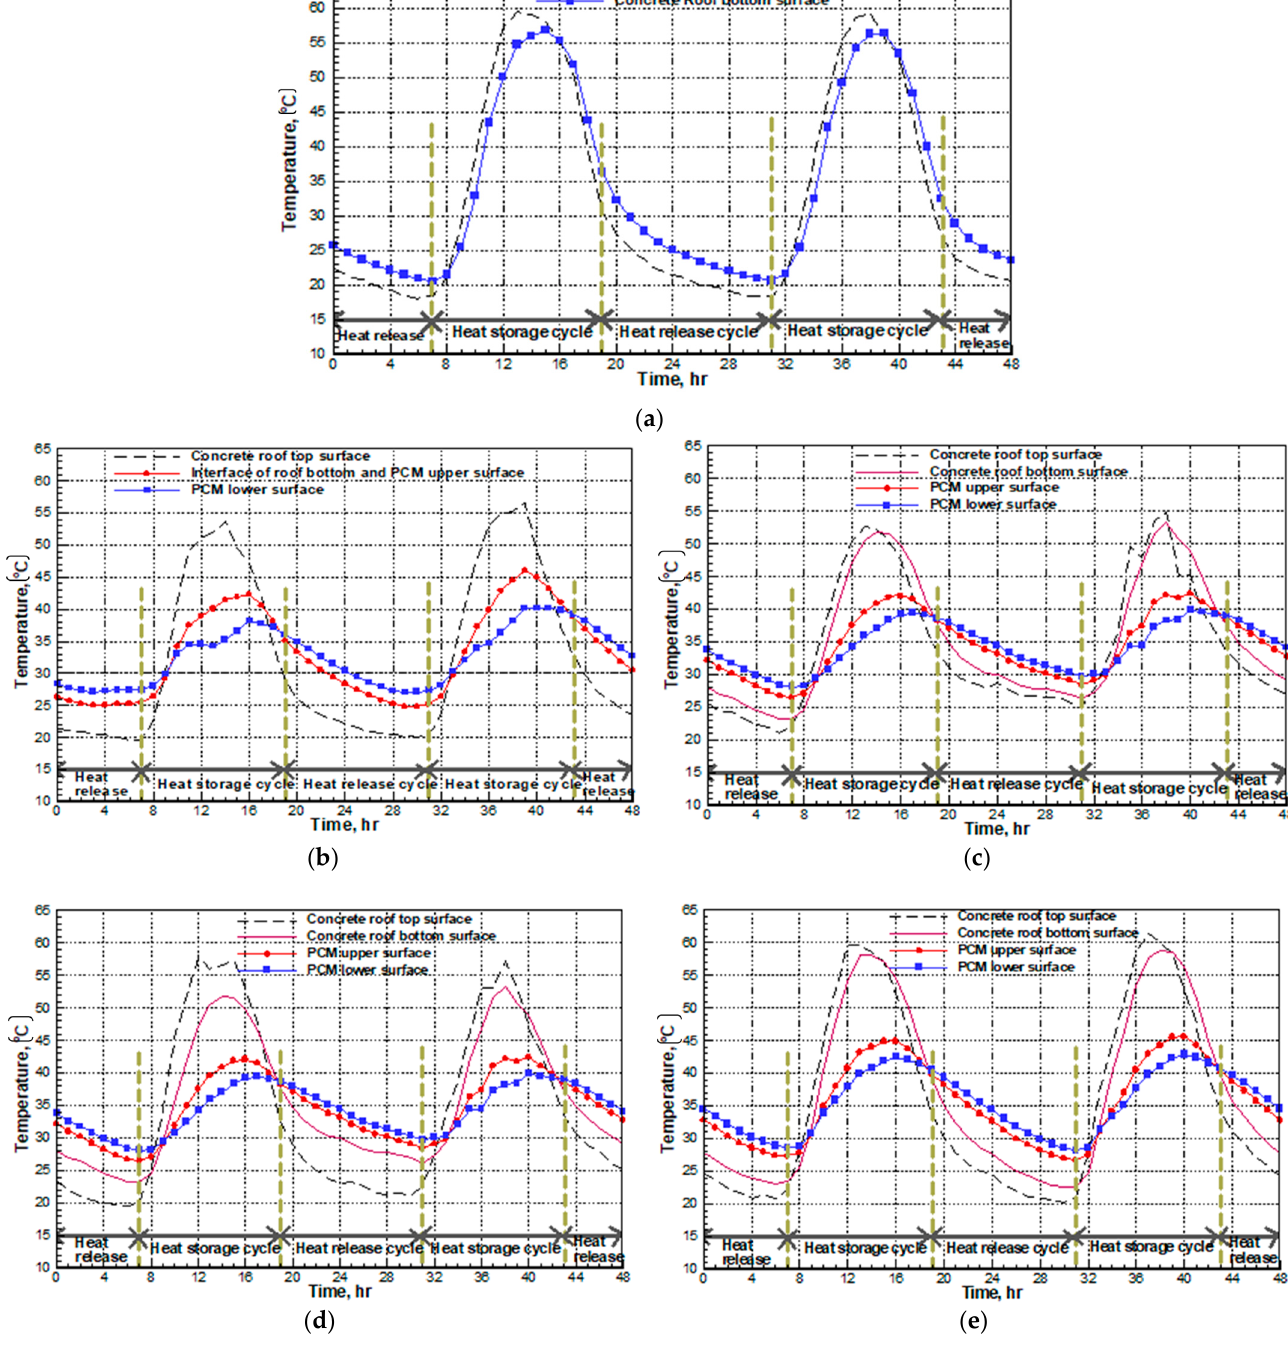
Figure 3. Temperature distribution across the roof slab. ( a ) Non-PCM; ( b ) PCM with 0 cm air layer; ( c ) PCM with 2 cm air layer; ( d ) PCM with 4 cm air layer; ( e ) PCM with 6 cm air layer.